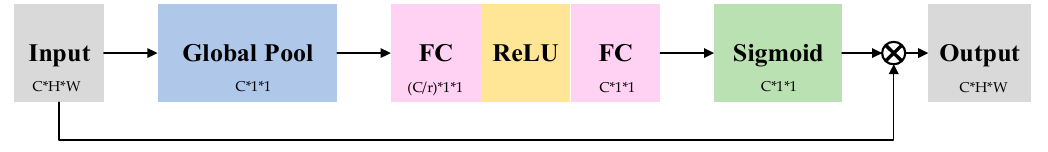
Figure 3. SENet attention structure diagram.